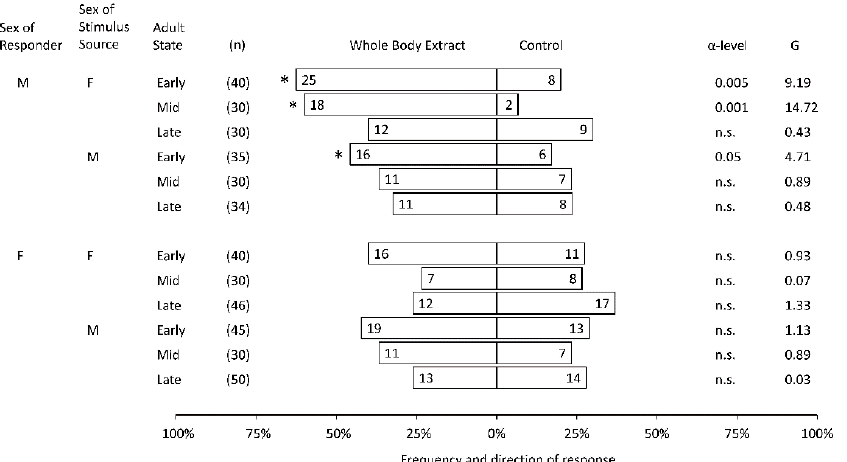
Figure 1. Frequency and direction of choices of individual adult male (M) and female (F) spotted lanternflies (SLF), Lycorma delicatula , from different adult physiological states, in response to volatiles from whole body extracts collected from male or female SLF (7.1 insect equivalents), tested against the solvent control in a dual-choice walking olfactometer. Asterisks indicate a significant difference between sides (Chi Square test). A test statistic (G) below 3.841 was not significant (n.s.), and the level of significance ( α ) is shown.